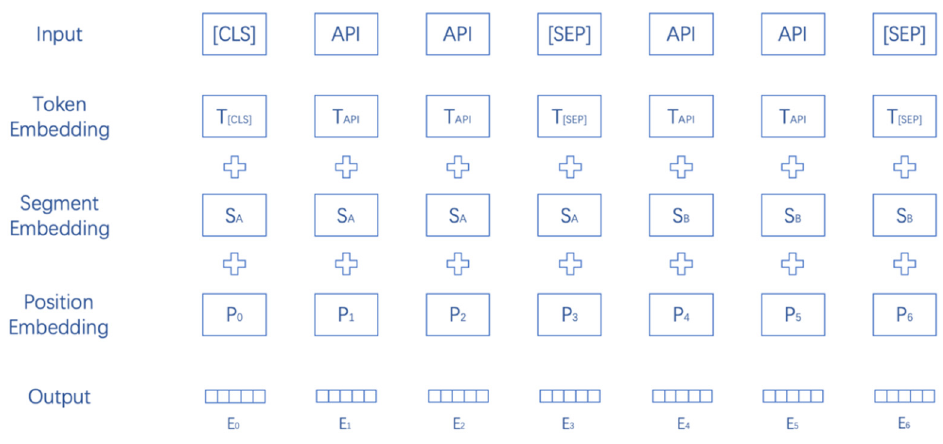
Figure 9. Input and output